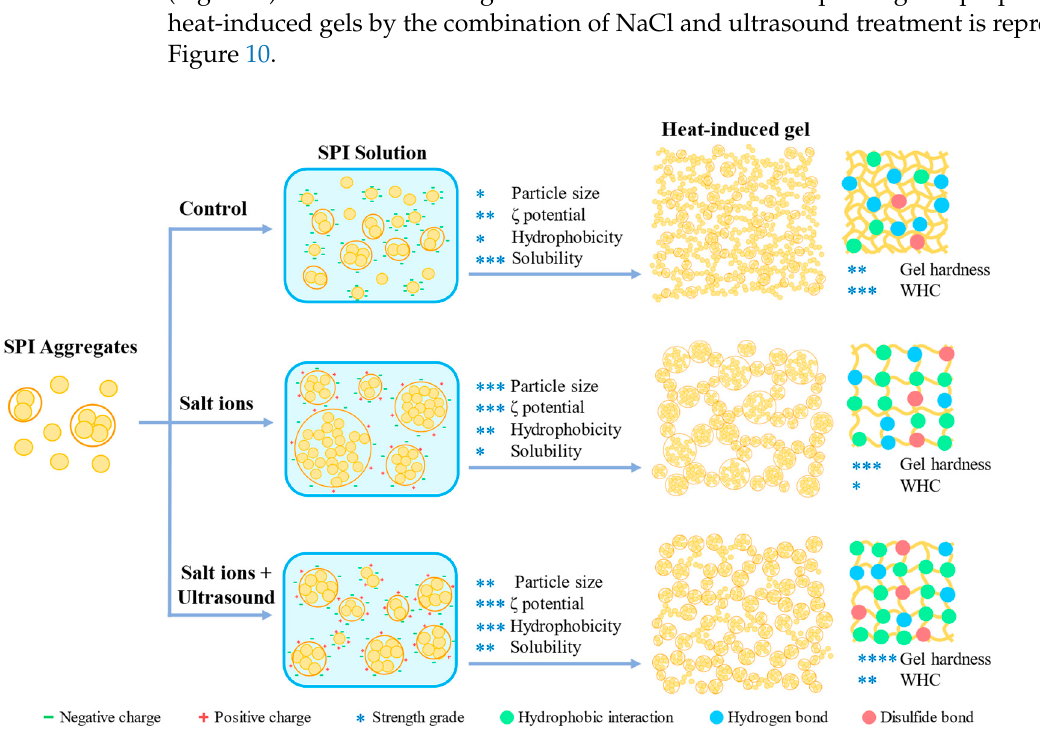
Figure 10. Schematic diagram of the mechanism of improving soy protein isolate heat-induced gel properties by combining NaCl addition and ultrasound treatment. *, **, *** and **** represent the values of the test index (particle size, ζ potential, hydrophobicity, solubility, gel hardness and